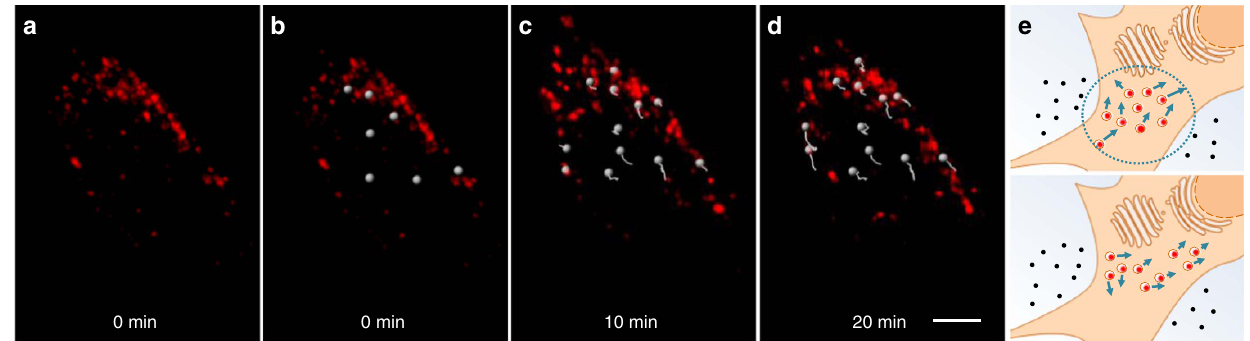
Figure 10 | Lysosome tracking in living HeLa Kyoto cells post 1h incubation with 2 (10 l M). ( a ) Time-lapse representative snapshot of a single cell chosen for image analysis. ( b ) Lysosome selection at 0min. ( c , d ) Tracking over time. ( e ) Schematic depiction of tracking intracellular vesicular movements with bioresponsive fluorophore. Scale bar, 5 m